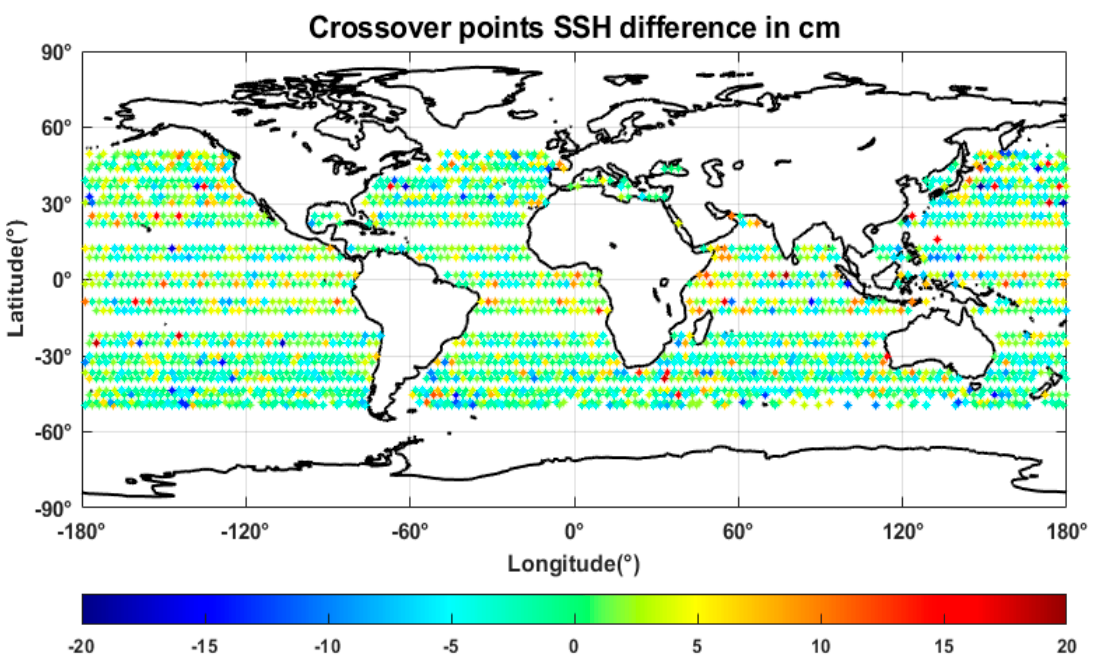
Figure 8. Distribution of the crossover points SSH difference for HY-2C using CMR_WTC.